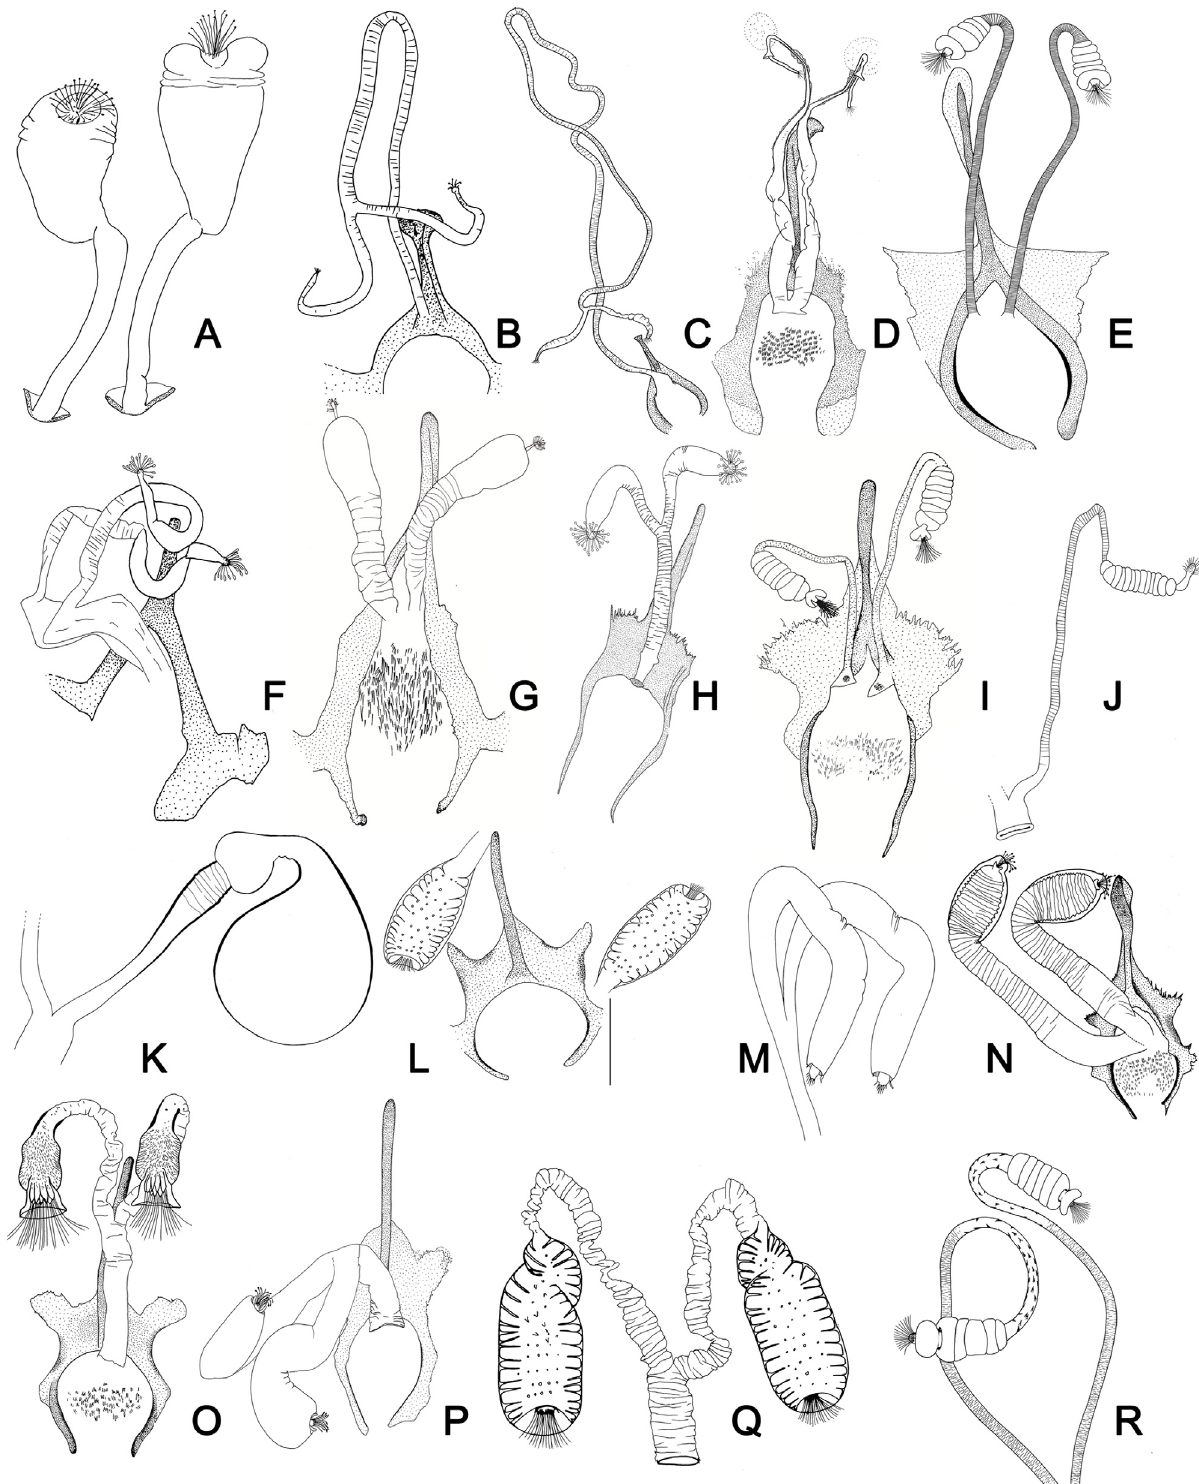
Figure 20. Spermathecae and genital fork aspects of Phlebotominae. (A) Australophlebotomus notteghemae ; (B) Chinius eunicegalatiae ; (C) Chinius samarensis ; (D) Phlebotomus ( Madaphlebotomus ) vincenti ; (E) Ph. ( Paraphlebotomus ) sergenti ; (F) Idiophlebotomus padillarum ; (G) Parvidens heishi ; (H) Ph. ( Euphlebotomus ) barguesae ; (I) Ph. ( Par. ) chabaudi ; (J) Phlebotomus ( Larroussius ) major ; (K) Spelaeomyia moucheti ; (L) Sergentomyia ( Rondanomyia ) goodmani comorensis ; (M) Se. hivernus ; (N) Ph. ( Transphlebotomus ) economidesi ; (O) Se. ( Vattieromyia ) namo ; (P) Se. ( Sergentomyia ) phadangensis ; (Q) Sergentomyia ( Ron. ) goodmani ; (R) Ph. ( Par. )